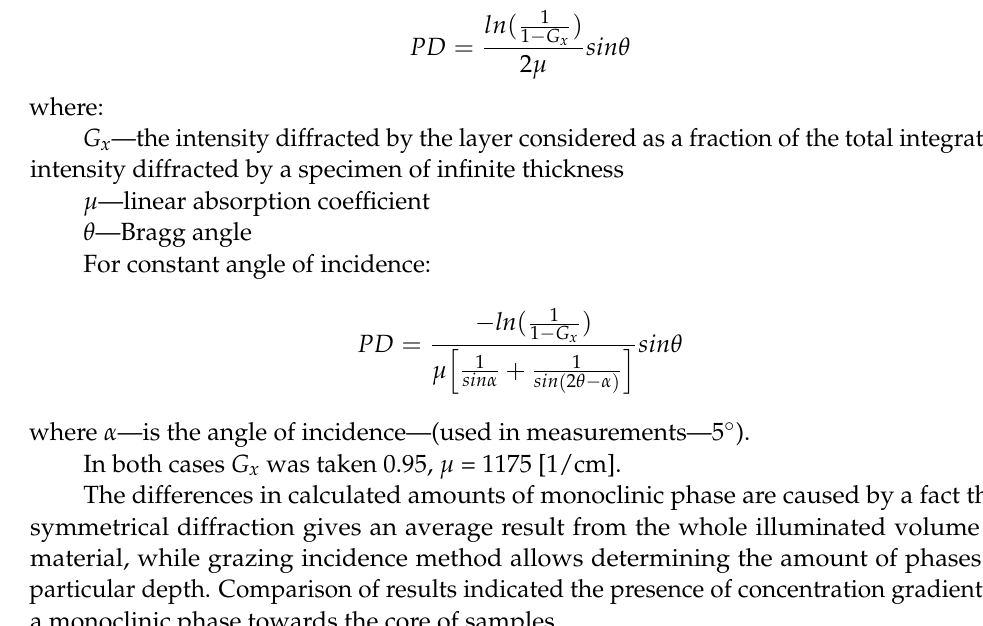
Figure 10. Penetration depth plot for grazing incidence diffraction- incident angle 5°.